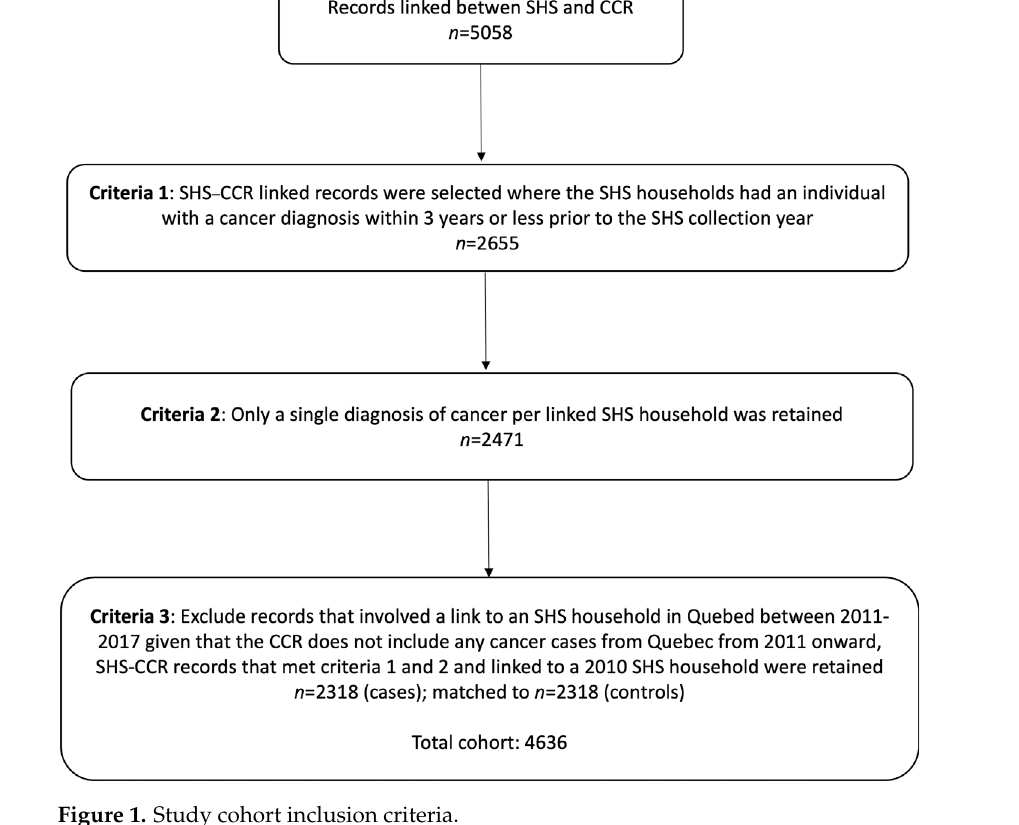
Figure 1. Study cohort inclusion criteria.